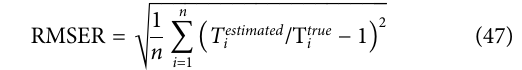
Frontiers in Built Environment |